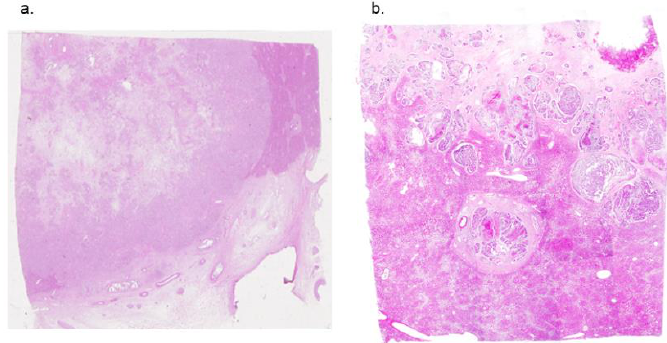
Figure 1. Hematoxylin and eosin-stained liver samples ( a , b ).